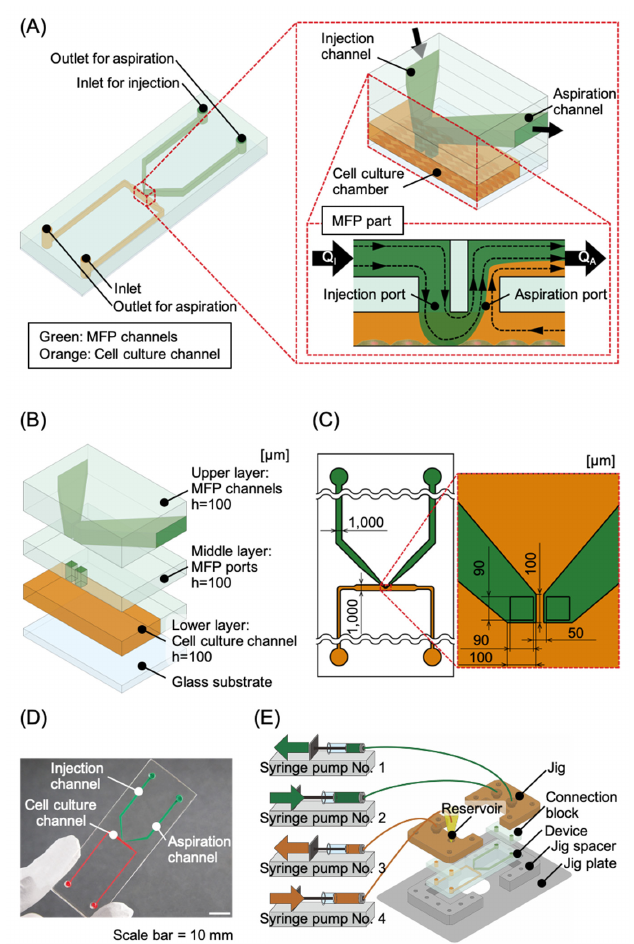
Figure 1. Conceptual diagram of the microfluidic probe (MFP) integrated device. ( A ) MFP integrated device design. The device consists of an MFP channel (indicated in green) and a cell culture channel (indicated in orange). To obtain a localized chemical stimulation area, flow ratios are set such that Q I < < Q A . ( B ) The device is composed of four layers: upper, middle, lower, and a glass substrate. The upper, middle, and lower layers correspond to the MFP channels, the MFP ports, and the cell culture channel, respectively. ( C ) Scale diagram of the channel section of the device. The major portion of each MFP channel and the cell culture chamber have a channel width and height of 1 mm and 100 μ m, respectively. ( D ) Photograph of the device made from polydimethylsiloxane (PDMS) using photolithography. An inlet and outlet are fabricated at each microchannel in this device. ( E ) Experimental setup. Thick PDMS connection blocks are attached to the locations of the inlets and the outlets for installation in a jig connected to syringe pumps. Syringe pumps no. 1 and no. 2 are connected to the MFP channels and are used for fluid control in the chemical stimulation area. Syringe pumps no. 3 and no. 4 are connected to the cell culture channel, and are used for cell culture, solution replacement, and other related activities. The device with the jig is installed onto the stage of a confocal